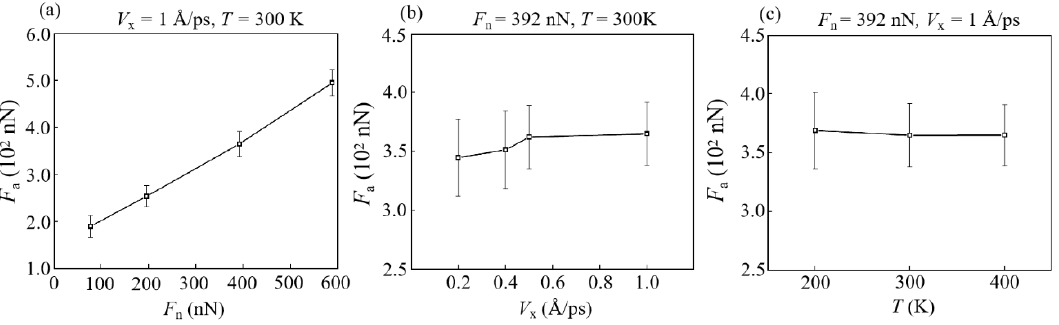
Figure 3. Effect of different conditions on the average friction force F a : ( a ) V x = 1 Å /ps, T = 300 K; ( b ) F n = 392 nN, T = 300 K; ( c ) F n = 392 nN, V x = 1 Å /ps. ( b ) F n = 392 nN, T = 300 K; ( c ) F n = 392 nN, V x = 1